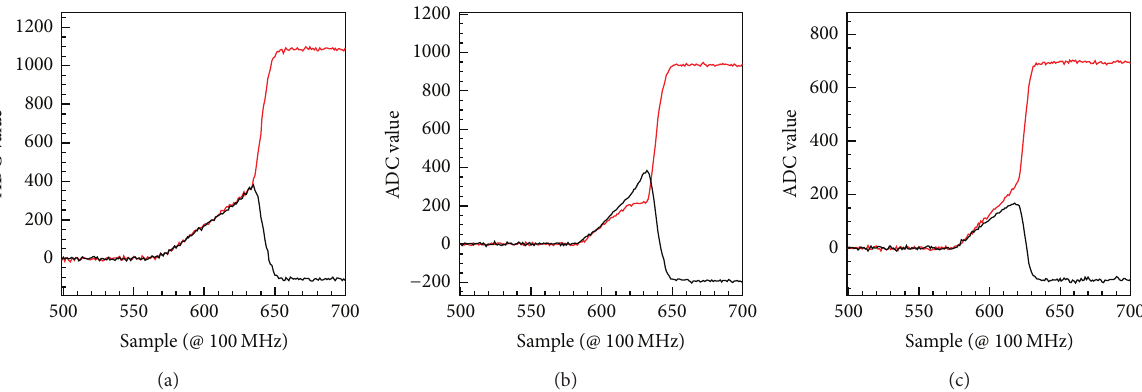
Figure 5: Pulses from the two anodes. (a) Typical central event. (b) and (c) Lateral surface events showing distortions.